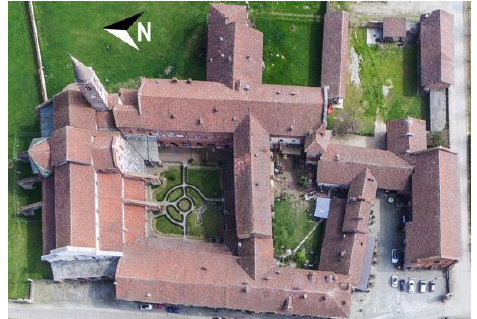
Figure 1. Staffarda Abbey view form APR (M. Roggero)